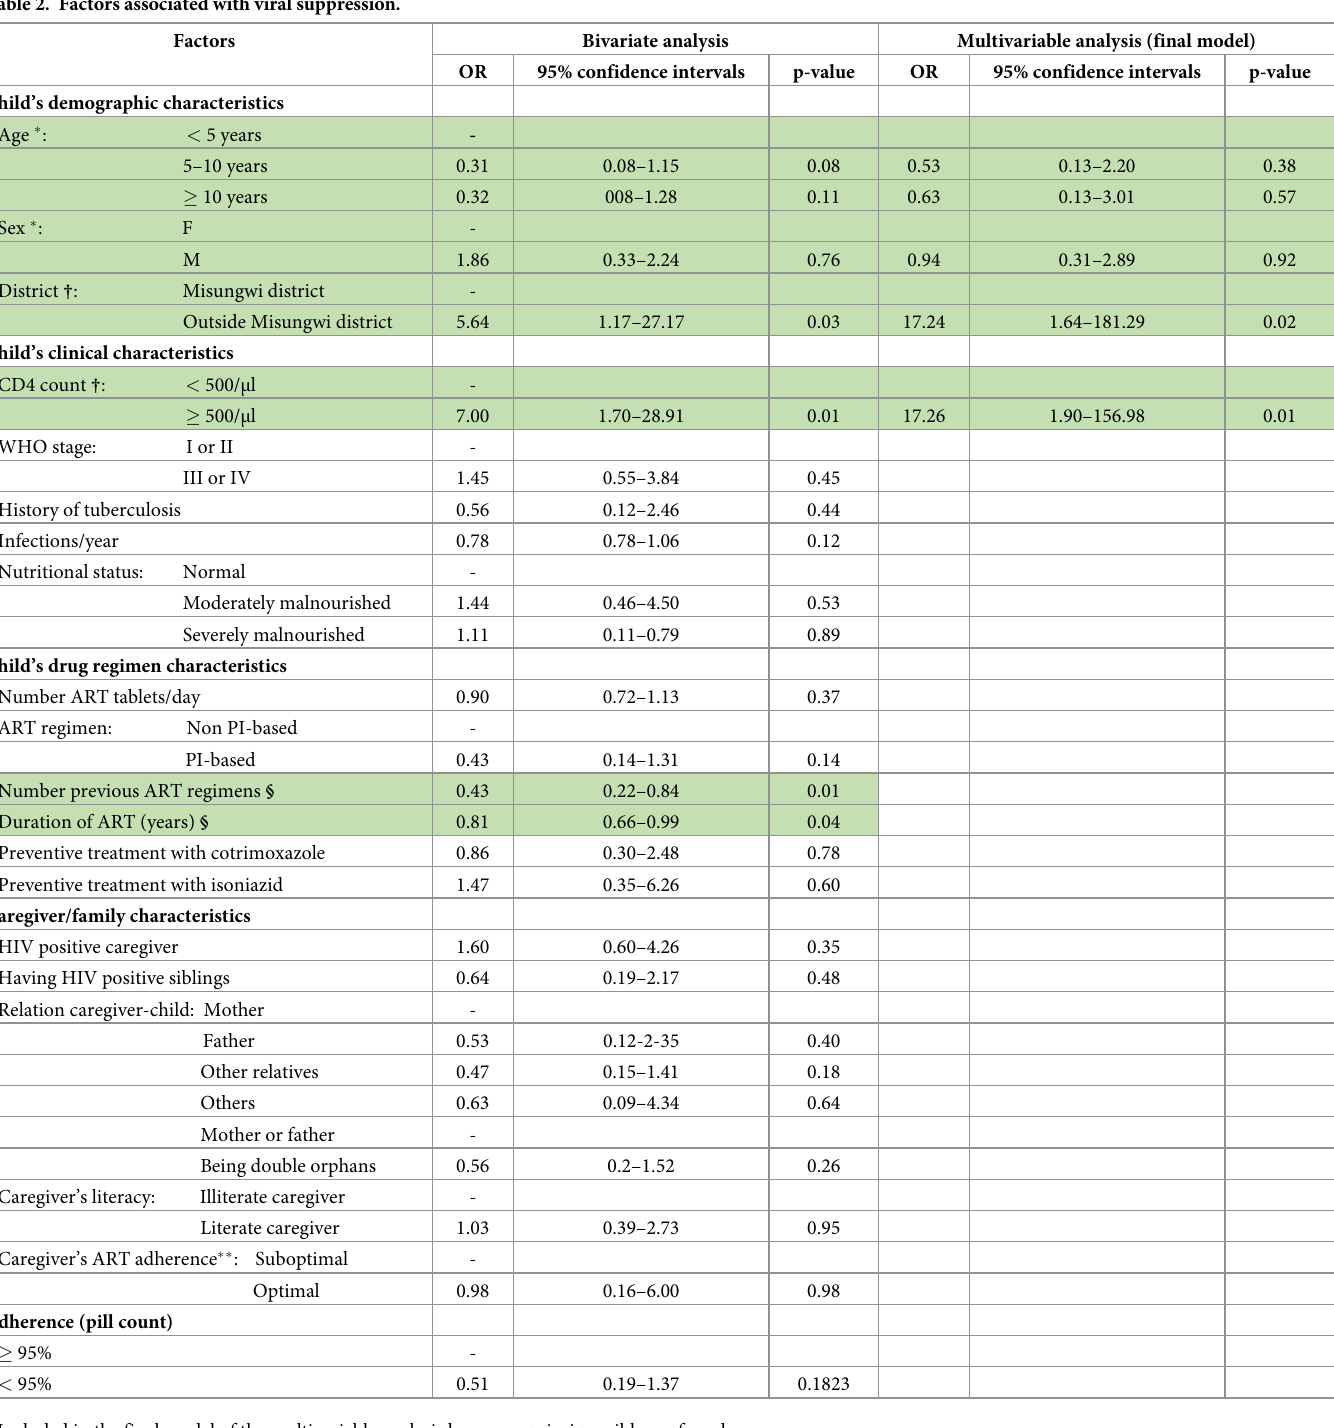
Table 2. Factors associated with viral